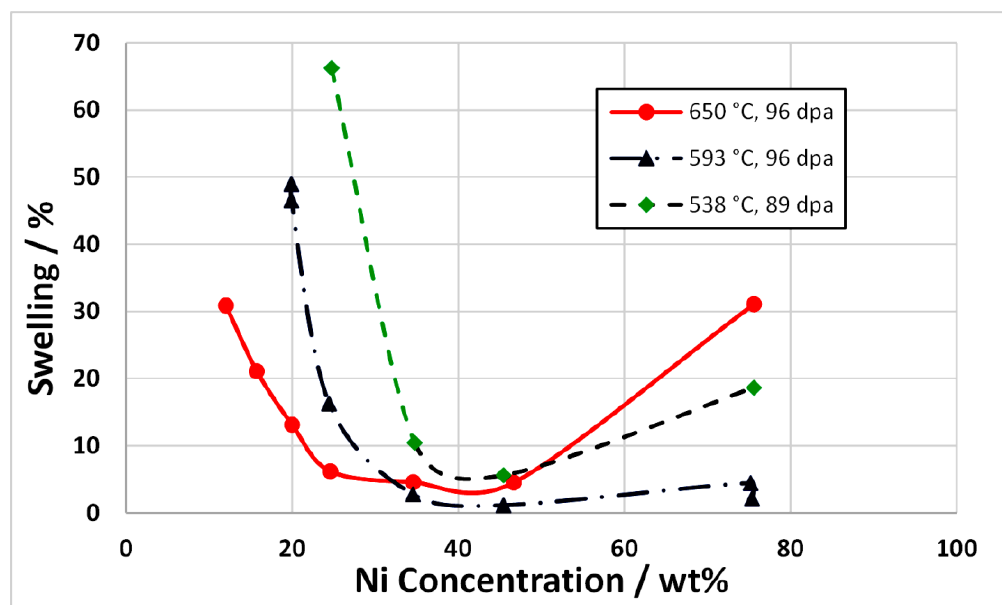
Figure 23. Dependence of swelling on nickel content of Fe–15Cr–Ni ternary alloys irradiated in EBR-II to doses of approximately 100 dpa, showing a minimum in swelling in the 30–50 Ni range, depending on temperature. Modified from [3].